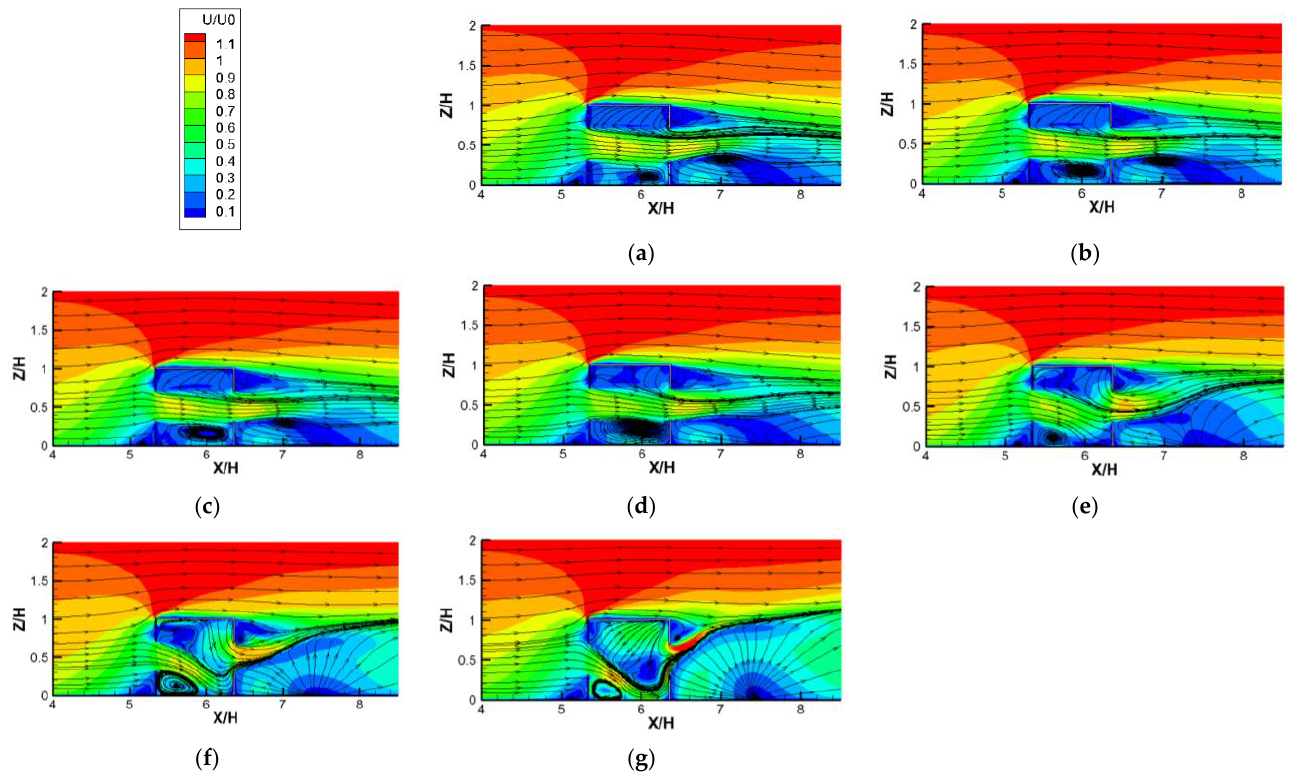
Figure 8. Contours of dimensionless velocity ( U / U 0 ) against increasing Ri numbers for cross-ventilation cases. ( a ) Ri = 0; ( b ) Ri = 0.04; ( c ) Ri = 0.27; ( d ) Ri = 1.86; ( e ) Ri = 5.31; ( f ) Ri = 11.11; ( g ) Ri = 26.65.